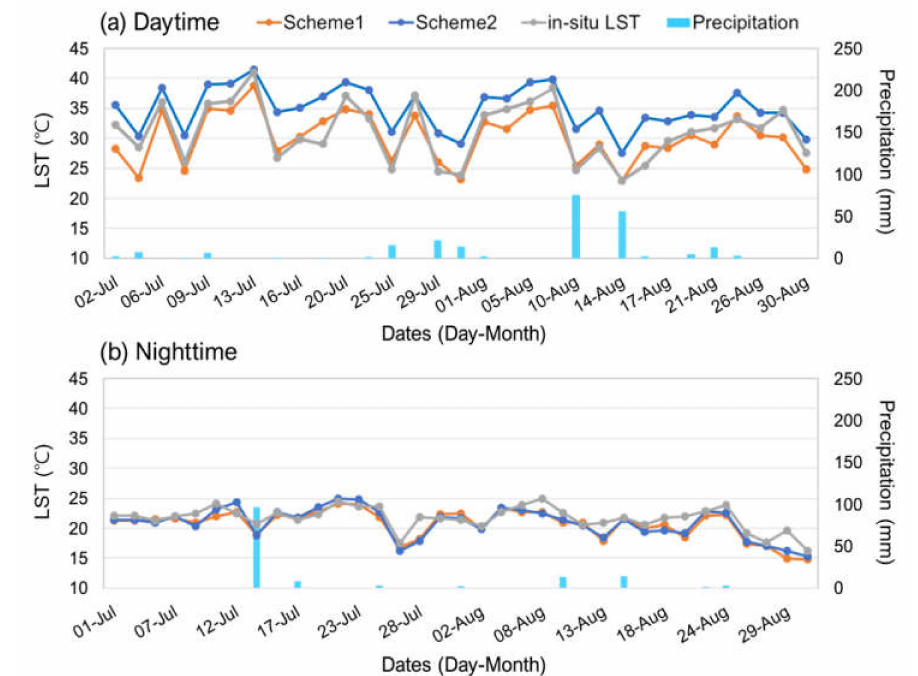
Figure 10. Time-series of the estimated LSTs for schemes 1(S1) and 2(S2), and 1 km bias-corrected in situ LSTs with daily precipitation at station 9 for ( a ) daytime and ( b ) nighttime during July and August in 2017 (except the missing days due to advanced microwave scanning radiometer (AMSR2) gaps between paths). Daily precipitation data were obtained from automated surface observing systems (ASOSs) operated by the Korea Meteorological